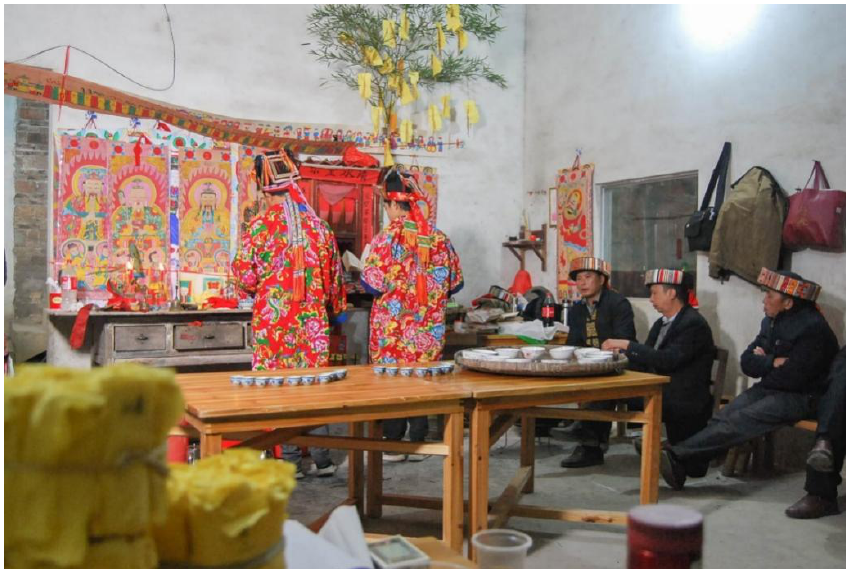
Figure 8. Two of the apprentices chanting the scriptures while worshipping the dragon. C8, Reciprocating Ji Bing Yuan (huan ji bing yuan, 還祭兵願 ). The masters started to